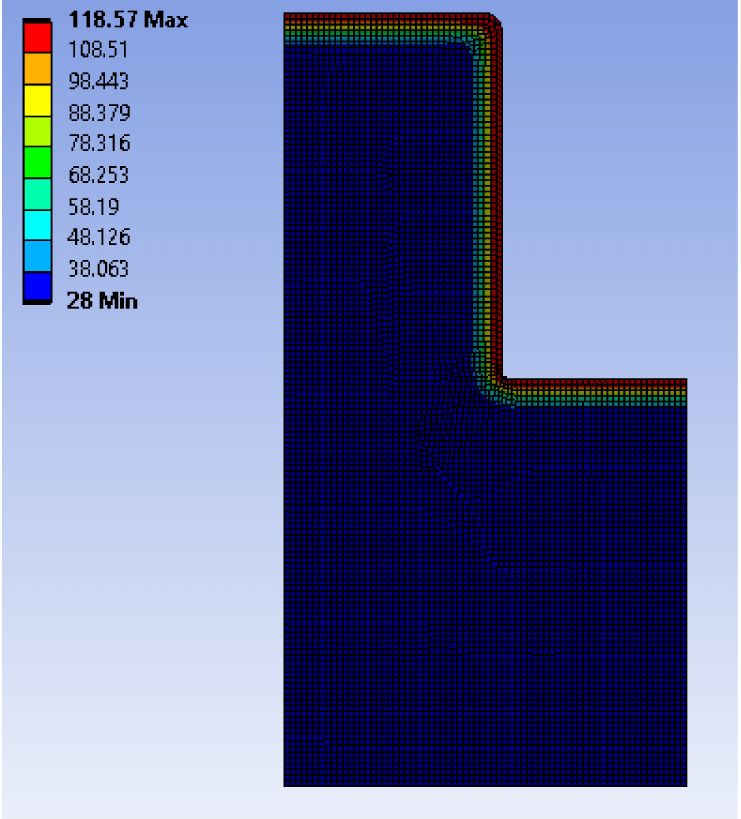
Figure 19. Temperature gradient on the M5 core pin; the pin is shown as a 2D axis symmetrical